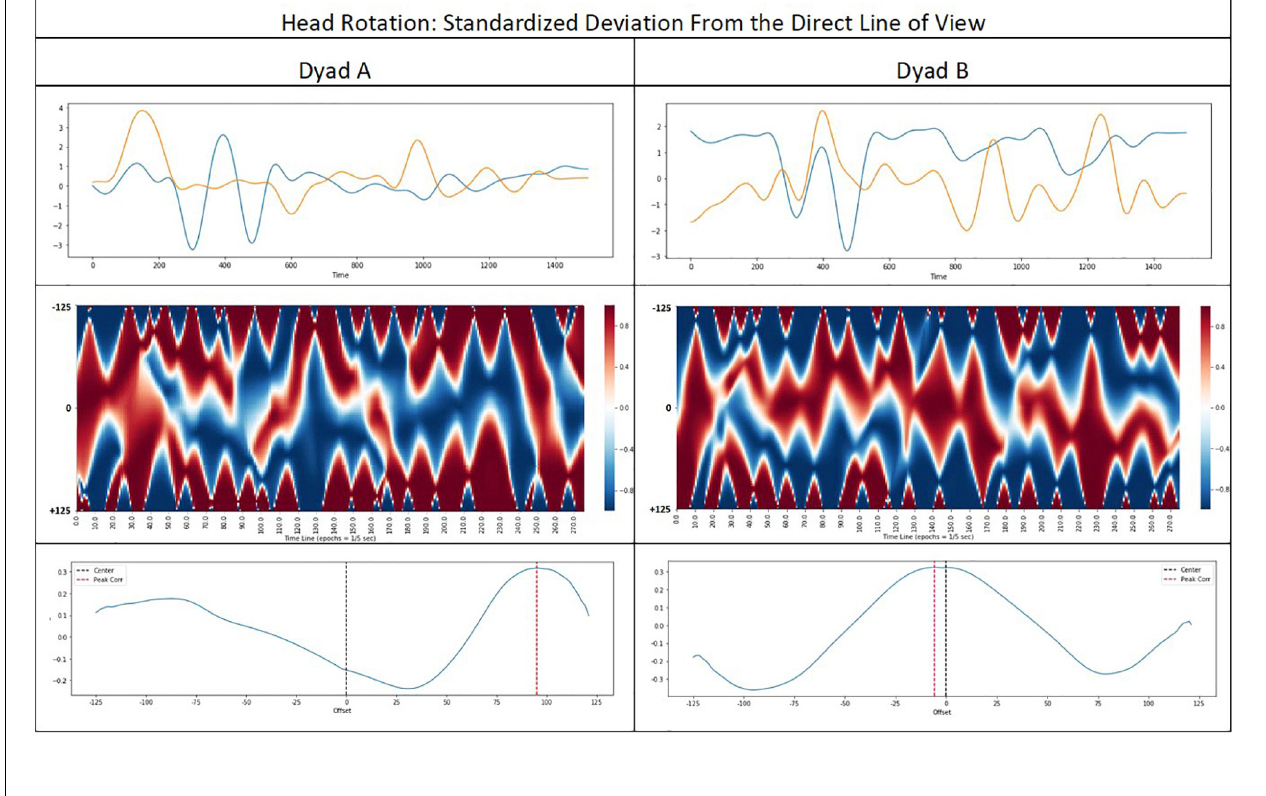
FIGURE 8 | Results of RWTLCC for the head rotation dynamics of 2 dyads differing in the peak correlation offset. The upper graphs show the low pass filtered, standardized head rotations. The mid graphs show the time lagged correlations with lags of ± 5 s ( ± 125 data points) and a moving window with a step size of 0.2 s (5 data points). The lower graphs show the mean correlations for the time lags from –125 to +125 datapoints.